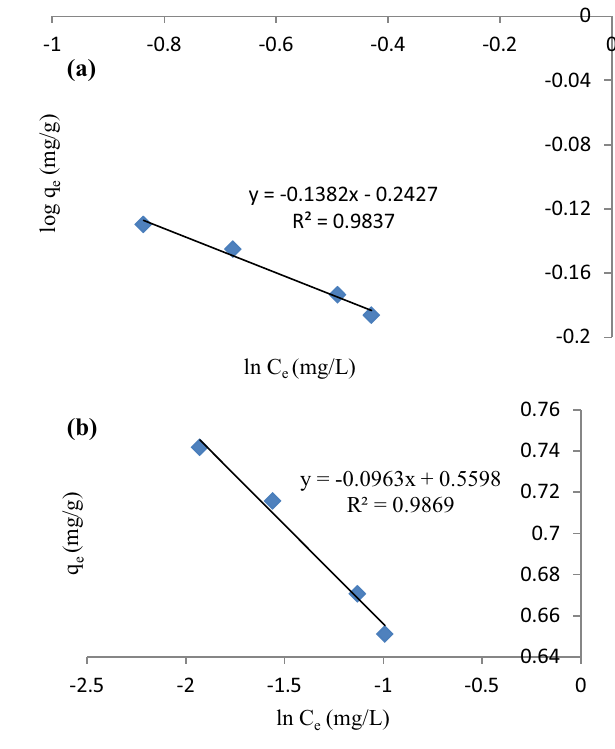
Fig. 3 a Temkin Isotherm for effect of initial fluoride ion concentra- tion on defluoridation (Acid treated Moringa oleifera leaves